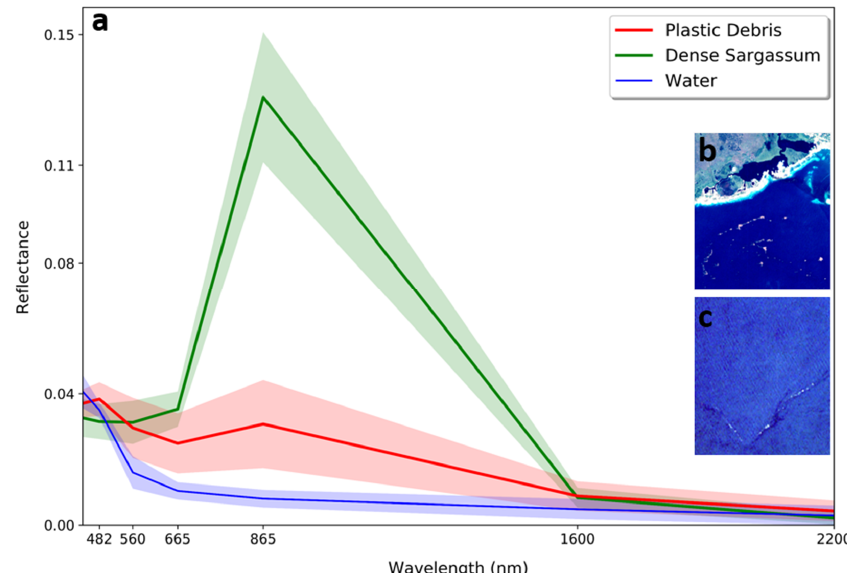
Figure 1. The systematically recorded, from the multispectral remote sensing data, spectral signatures of plastic debris, dense Sargassum and seawater along with their standard deviation (n = 1600). ( a ) Spectral signatures of plastic debris (red), dense Sargassum (green) and water (blue). ( b ) An indicative Planet image with dense Sargassum . ( c ) Indicative Planet image with plastic debris.